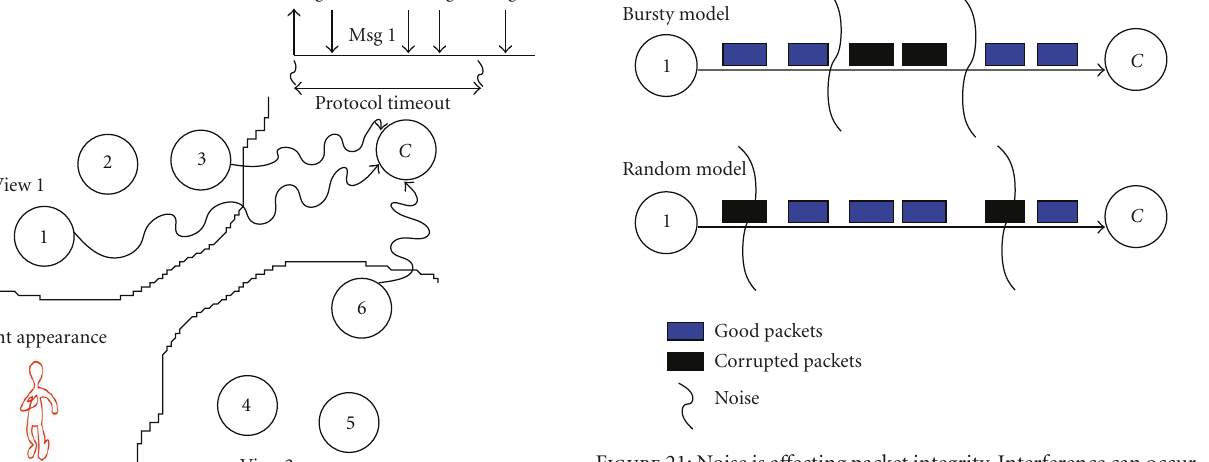
Figure 21: Noise is a ff ecting packet integrity. Interference can occur randomly or